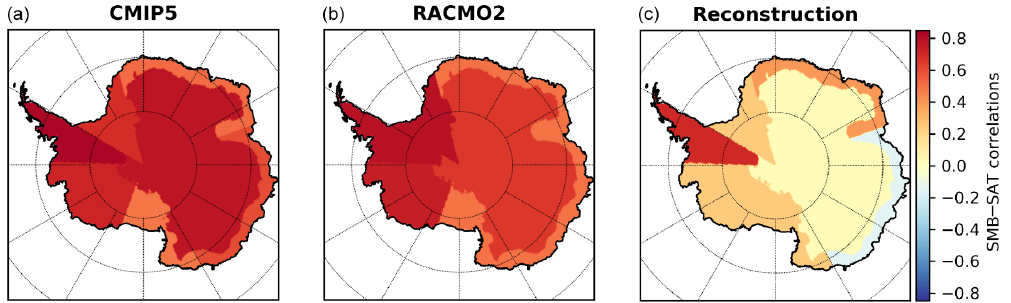
Figure 4. The 5-yearly correlations ( r ) between SMB and surface air temperature for the seven Antarctic regions (see Fig. 1 for geographical definitions) for GCMs over 1850–2000CE (a) , for RACMO2 over 1979–2016CE (b) , and for ice core reconstructions (Thomas et al., 2017; Stenni et al., 2017a) for 1850–2000CE (c) . For the CMIP5 models and RACMO2, their correlations are all statistically significant ( p value < 0.05). For the reconstructions, the statistically significant ( p value < 0.05) correlations are obtained for the Antarctic Peninsula and Dronning Maud Land coast. See Fig. S2 for the correlations for each CMIP5 model.